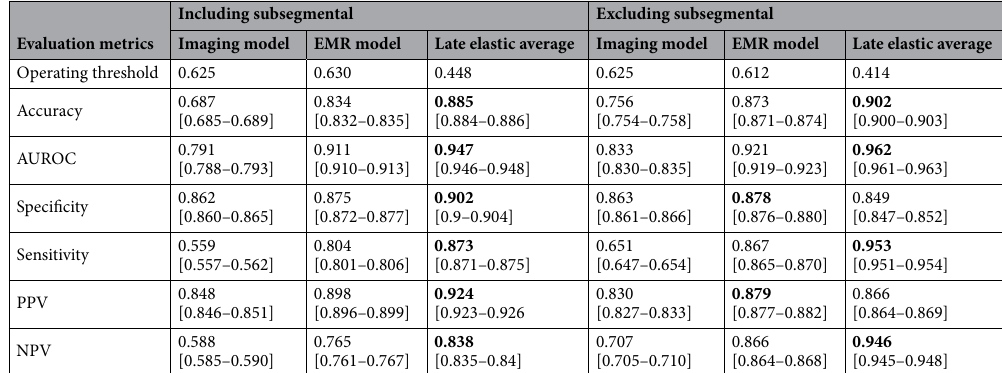
Table 3. Comparison between multimodality and the best performing single modality models. Model performance on the held-out testset with 95% confidence interval using probability threshold that maximizes both sensitivity and specificity on the validation dataset. Best performance metrics in bold